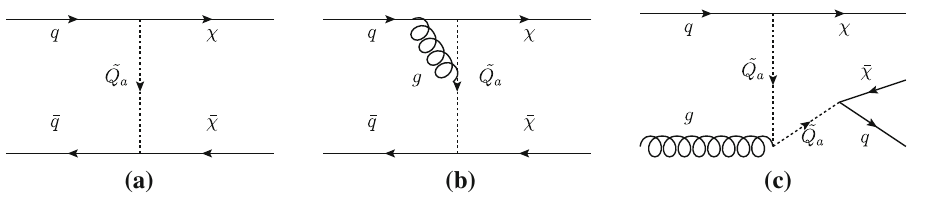
Fig. 2 Feynman diagrams for DM pair production in the t -channel model at LO order ( a ) and a representative diagram for the virtual corrections ( b ). In ( c ), a representative diagram for the real-emission corrections is shown where a scalar mediator can become resonant